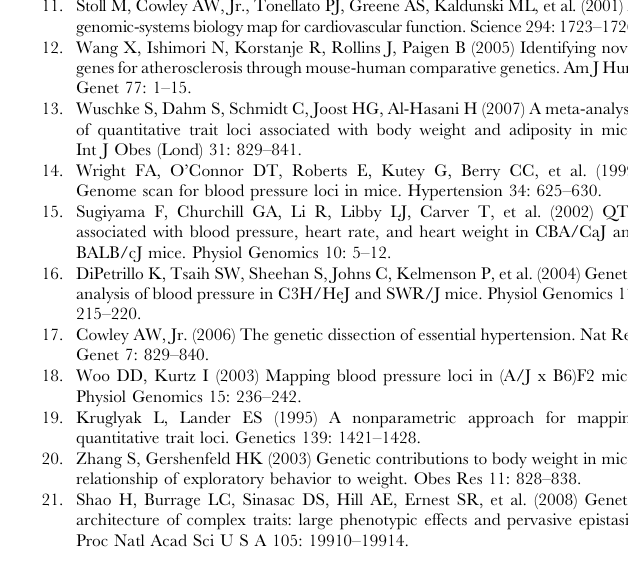
Table S11 Body Weight data for Akr1b8-/-, Emr1-/-, and Rgs2-/- and littermate controls.